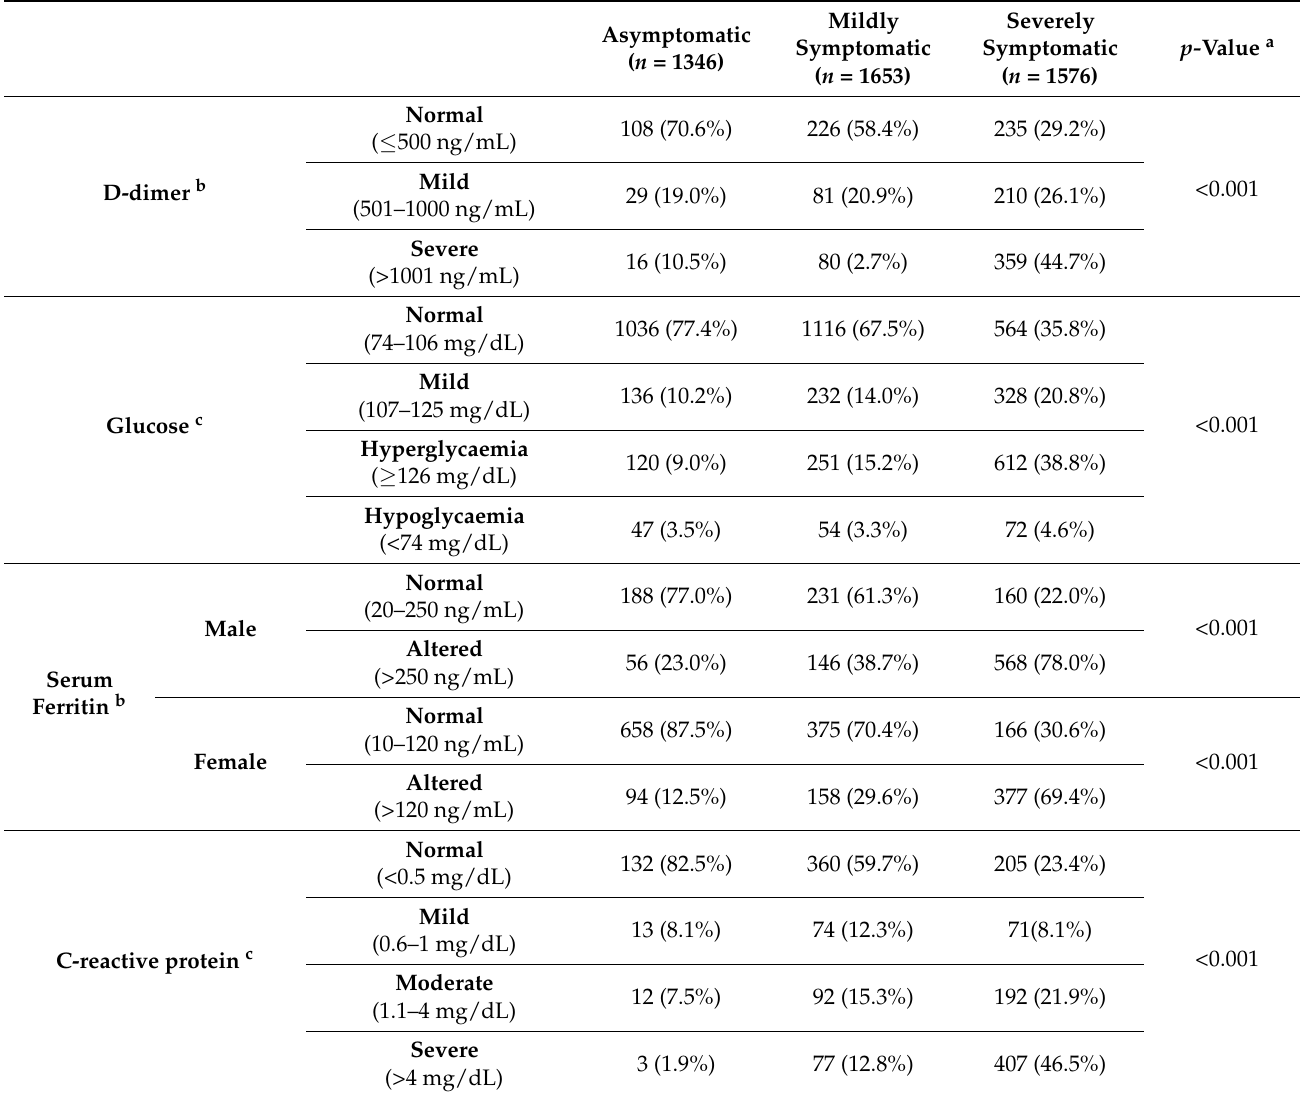
Table 3. Distribution of the alteration level of the analytical values in relation to the symptoms presented by the